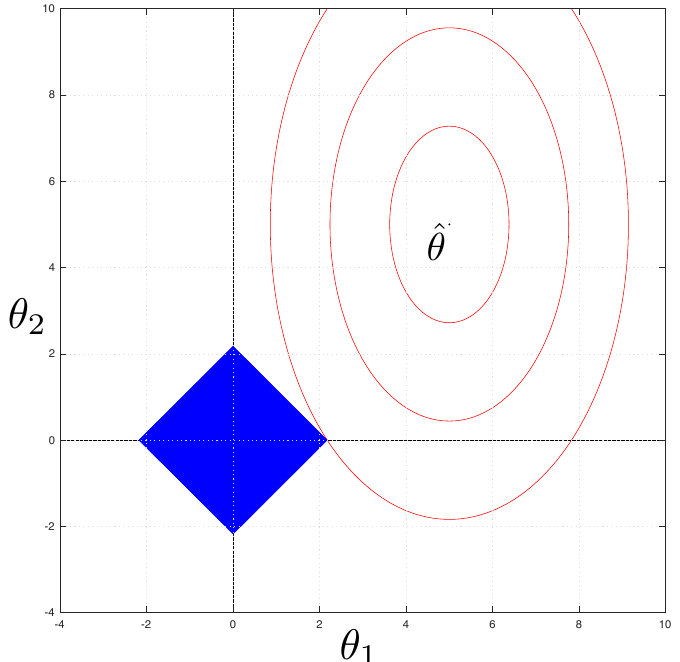
Figure 1. Graphical explanation of the sparsity induced by the lasso. In red are the contour lines of the standard loss while in blue is the region where ends up being on a vertex of the hyper